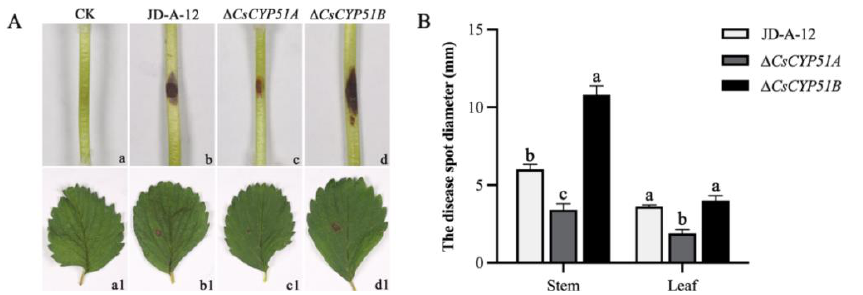
Figure 5. Pathogenicity of CsCYP51A and CsCYP51B mutants to strawberry leaves and stems. ( A ) JD-A-12, CsCYP51A, and CsCYP51B caused disease spots on the stem and leaf. ( B ) Pathogenicity difference analysis of JD-A-12, CsCYP51A, and CsCYP51B. Values with the same letters were not statistically different ( p > 0.05) according to the least significant difference (LSD) Test.